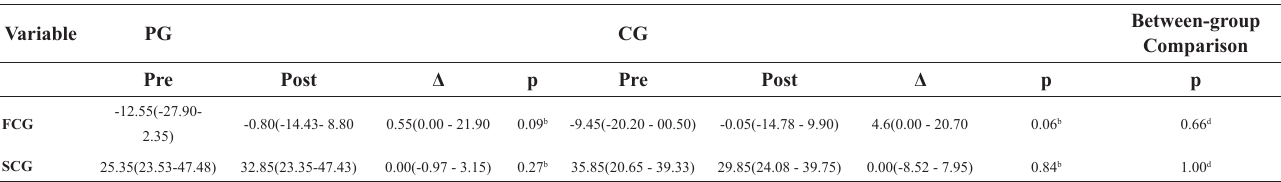
Between-group Comparison